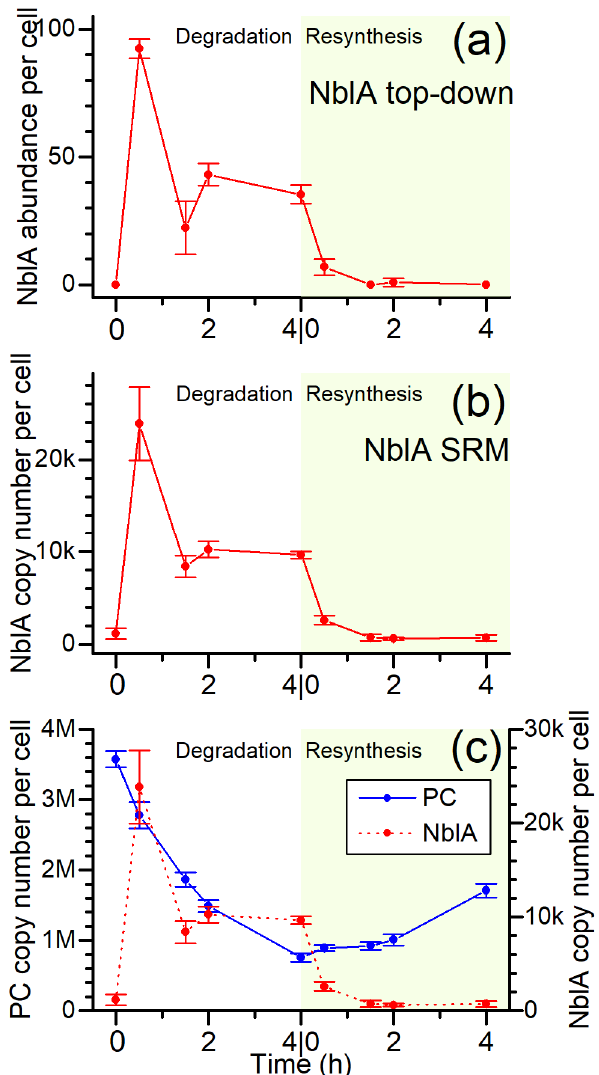
Figure 6. Change in NblA concentration over time as measured by ( a ) top-down proteomics and ( b ) selected reaction monitoring (SRM) bottom-up proteomics. Standard deviations of the measurements on 3 biological replicates are shown as error bars for the sample (red curve with filled circles). In bottom-up proteomics, the copy number of a NblA peptide MAHENIFK was calculated based on the mass spectrometry signal relative to an isotope labeled peptide as internal standard. In top-down proteomics, the mass spectrometry signal from intact NblA protein was directly used for label-free quantitation. Both methods showed a consistent result of spiking NblA concentration at the beginning of the degradation process (white background), and decreased concentration in the re-synthesis phase (green background). ( c ) Ratio of PC and NblA copy numbers during PBS degradation and re-synthesis. Number of NblA molecules was quantified by bottom up proteomics as in (b). PC abundance was calculated from absorbance values collected in Figure 1a,b. NblA and PC per cell were calculated by normalizing the abundance to cell number obtained by cell counting for each of the three biological replicates at every time point. Moles of PC were calculated using the formula provided in [9].